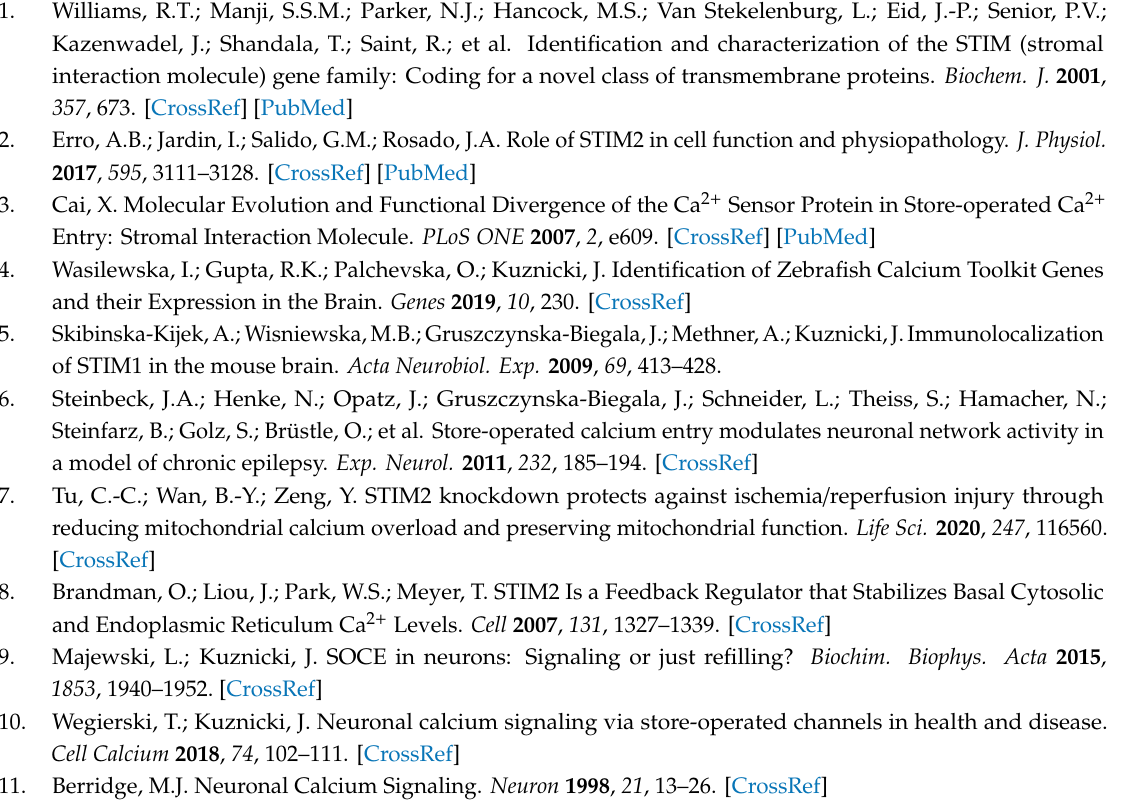
Table S1: RNAseq results of the di ff erential expression of genes in stim2b − / − larvae. Video S1: Ca 2 + oscillations in neurons of stim2b +/+ . Video S2: Ca 2 + oscillations in neurons of stim2b − / −